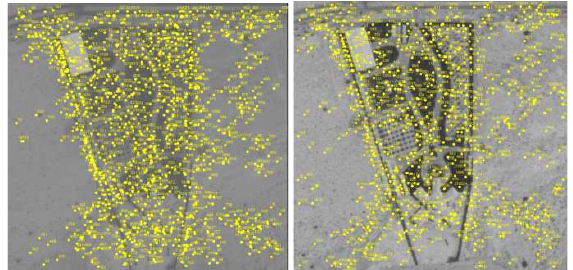
Figure 4. Key point distribution in agricultural area; IKONOS imagery (left); aerial orthophoto (right)